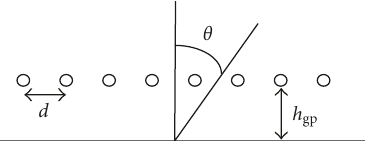
Figure 2: Schematic overview of the antenna array consisting of dipoles over an infinite ground plane. The distance from the ground plane is h gp and the spacing between the elements is d . The angle from the normal to the antenna axis is denoted by θ